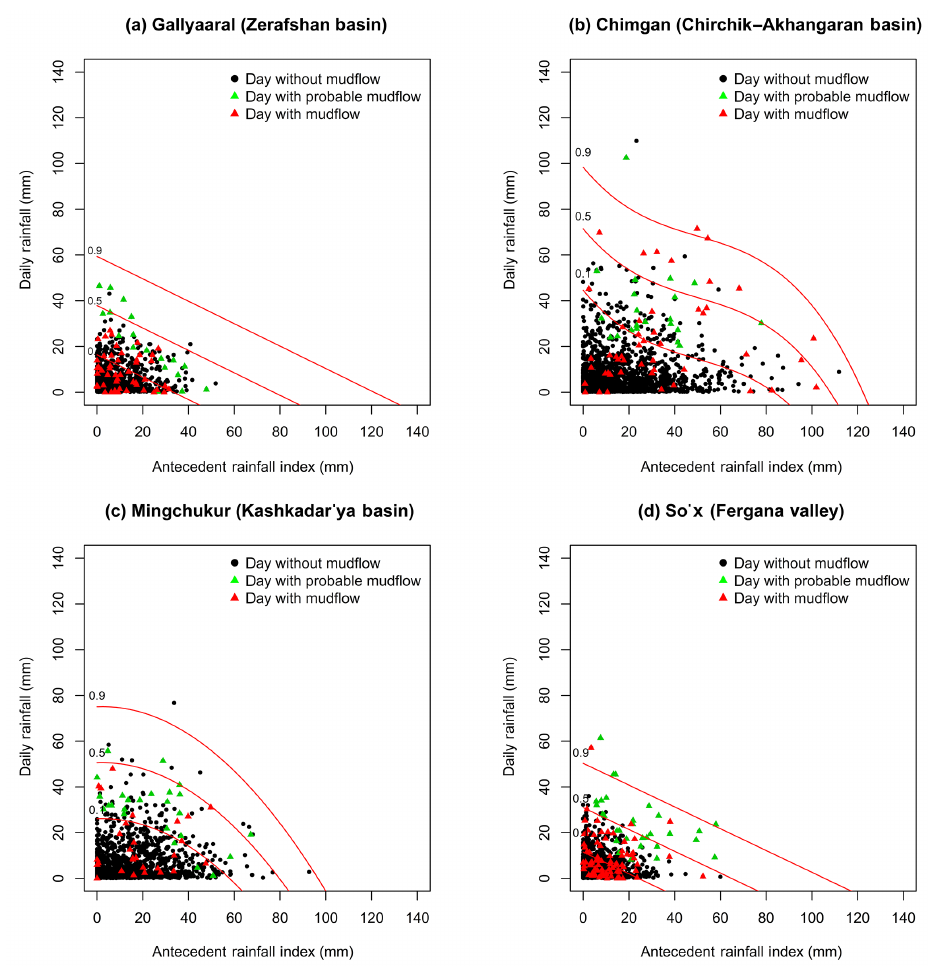
Figure 14. An antecedent daily rainfall model applied to the representative stations Gallyaaral (a) , Chimgan (b) , Mingchukur (c) and So’x (d) for the period 1984–2013. Red lines and curves indicate the 0.1, 0.5 and 0.9 probability threshold triggering mudflow occurrences. Equations from Table 4 were used for calculation of the probability lines at selected